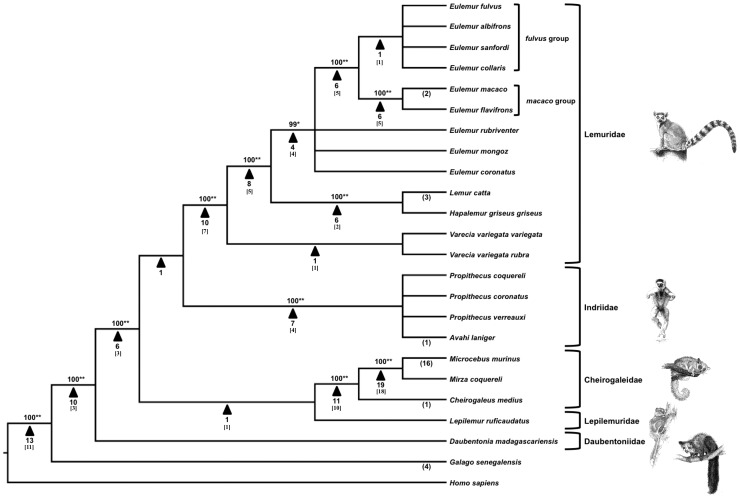
The most parsimonious tree generated from analysis of 138 Alu insertions in Lemuriformes.The amplification patterns of the Alu insertions were used to construct a Dollo parsimony tree of phylogenetic relationships with G. senegalensis and H. sapiens as outgroups using the MESQUITE and PAUP* programs. Numbers above branches are bootstrap values. The significance level of each node supported by insertions as determined by likelihood testing is indicated by either *(p<0.05) or **(p<0.01). Numbers below arrows indicate the number of unambiguous loci supporting that node. Numbers in brackets below arrows indicate the number of loci at a given informative node identified by McLain et al. (2012). Numbers in parentheses represent insertions that are only present in one species or group. These insertions are not parsimony-informative. Consistency index (CI): 1.000; Homoplasy index (HI): 0.000; Retention index (RI): 1.000.